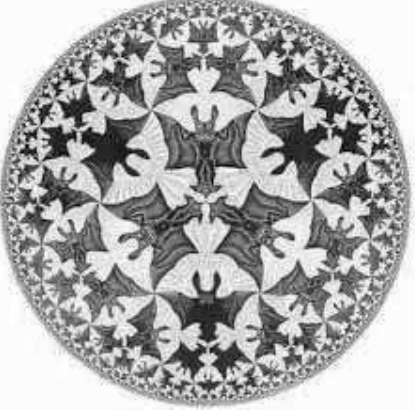
Figure 1. Circle limit IV (M. C. Escher) Source: